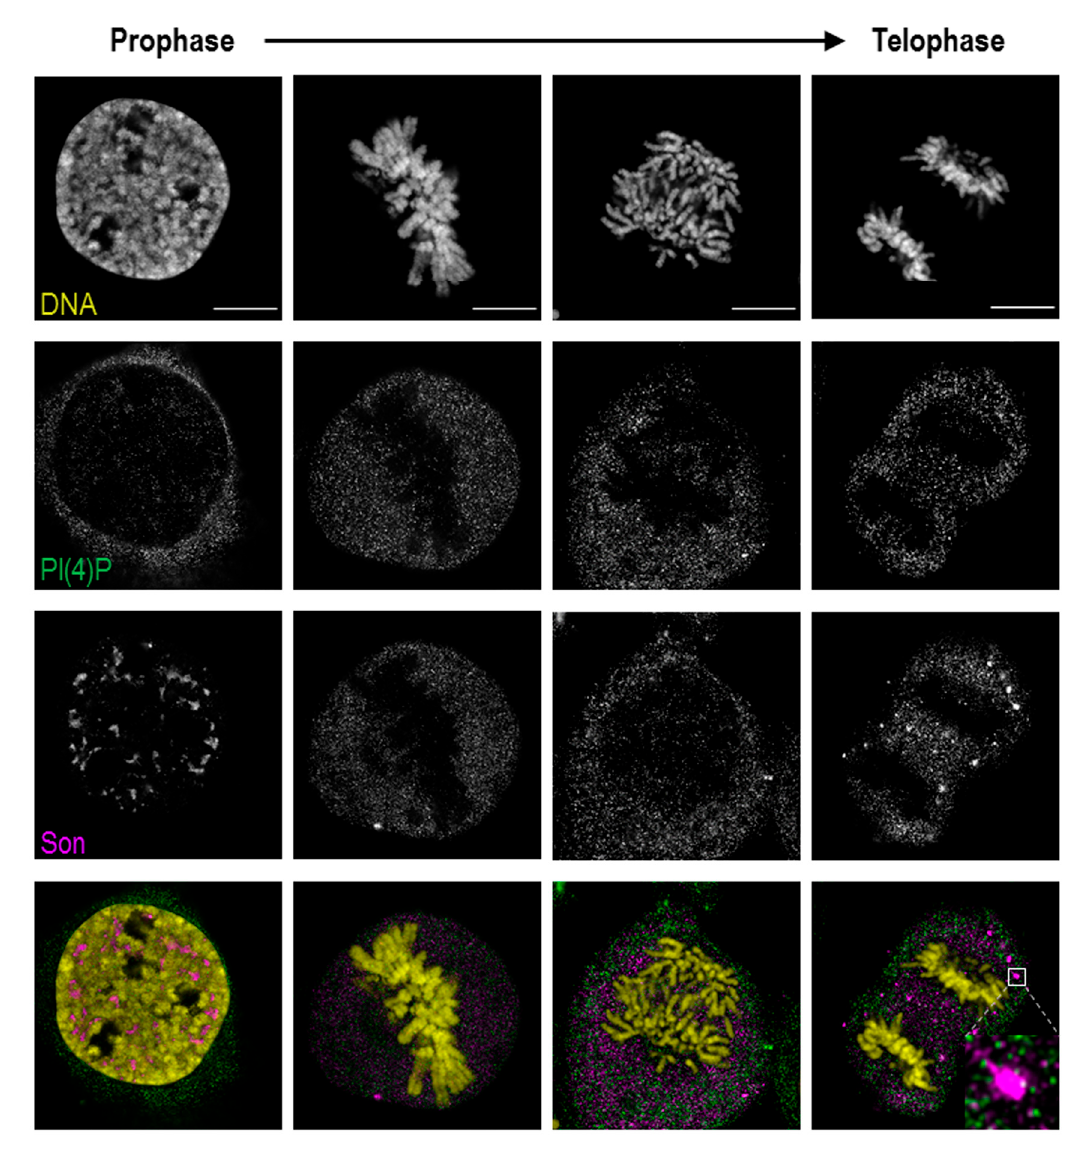
Figure 6. PI(4)P is dispersed in the cytoplasm during mitosis. PI(4)P and Son were labelled, and their localisation was followed across mitotic stages by super-resolution STED microscopy. PI(4)P does not localise to chromatin, nucleolar organising regions (NORs) or mitotic interchromatin granules (MIGs) during cell division. DNA was stained by DAPI. Scale bars: 10 μ m.